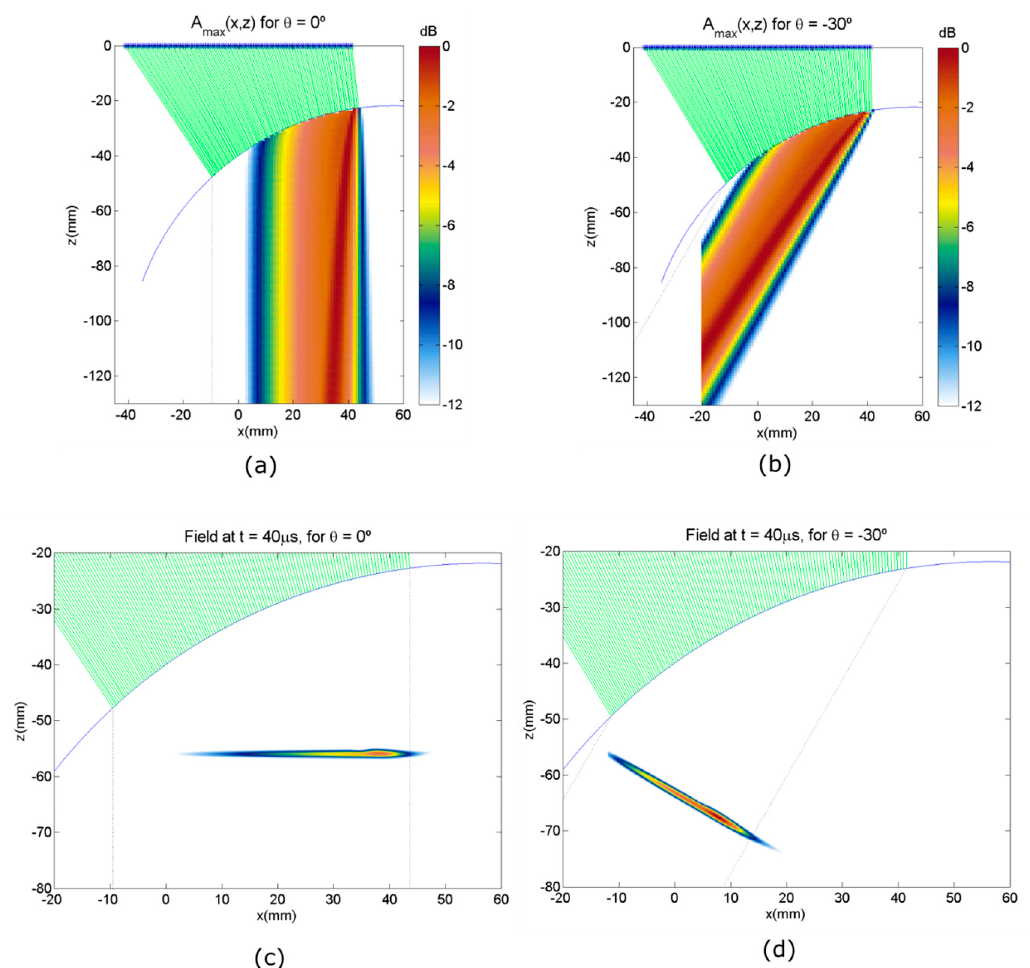
Figure 2. Pulsed wave simulation of a plane wave into a 50 mm radius cylindrical aluminum component. ( a ) Maximum amplitude for θ = 0 ◦ . ( b ) Maximum amplitude for θ = − 30 ◦ . ( c ) Instantaneous field for θ = 0 ◦ t = 40 µ s. ( d ) Instantaneous field for θ = − 30 ◦ , t = 40 µ s.